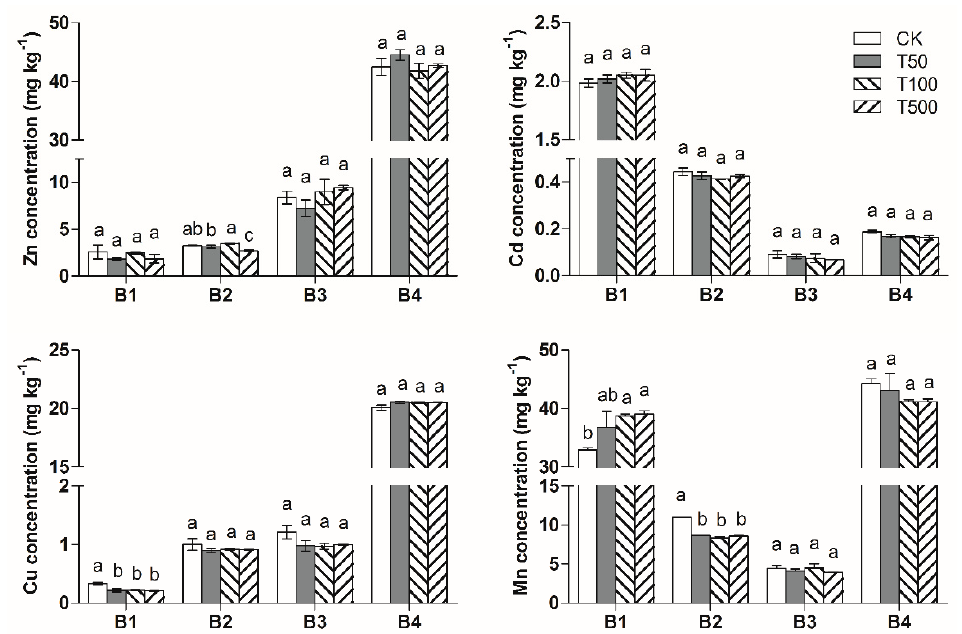
Figure 2. Changes in the chemical speciation of soil heavy metals with TiO 2 -NPs addition. B1: acid-soluble fraction; B2: Fe/Mn oxides-bound fraction; B3: organic-bound fraction; B4: residual fraction. Different letters above each column indicate significant difference ( p < 0.05) between various treatments.